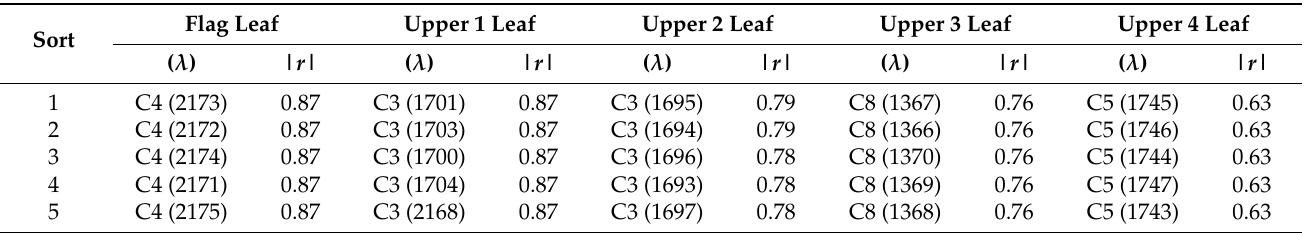
Table 6. Correlations of different leaf position wavelet coefficients and leaf nitrogen content in winter